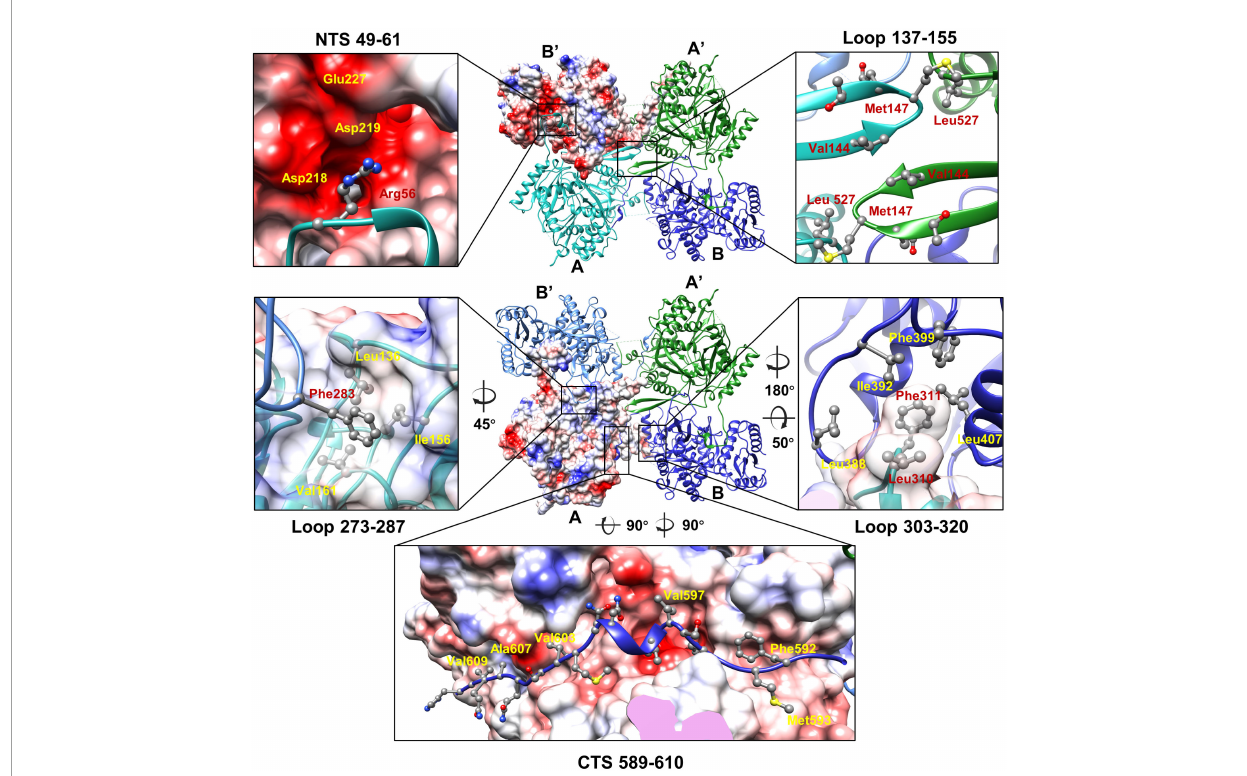
FIGURE5 The interactions between the monomers of the gp105 concave tetramer. Top: The molecule B’ is shown in a surface rendered representation. Other three molecules are shown in ribbon and colored cyan (molecule A), green (molecule A’), and dark blue (molecule B). Bottom: The molecule A is shown in a surface rendered representation. Other three monomers are shown in ribbons and colored green (molecule A’), dark blue (molecule B), and light blue (molecule B’). The surface is colored according to the surface electrostatic potential with red representing negative electrostatic potential and blue representing positive electrostatic potential. The key residues at the interface are shown in balls and sticks.